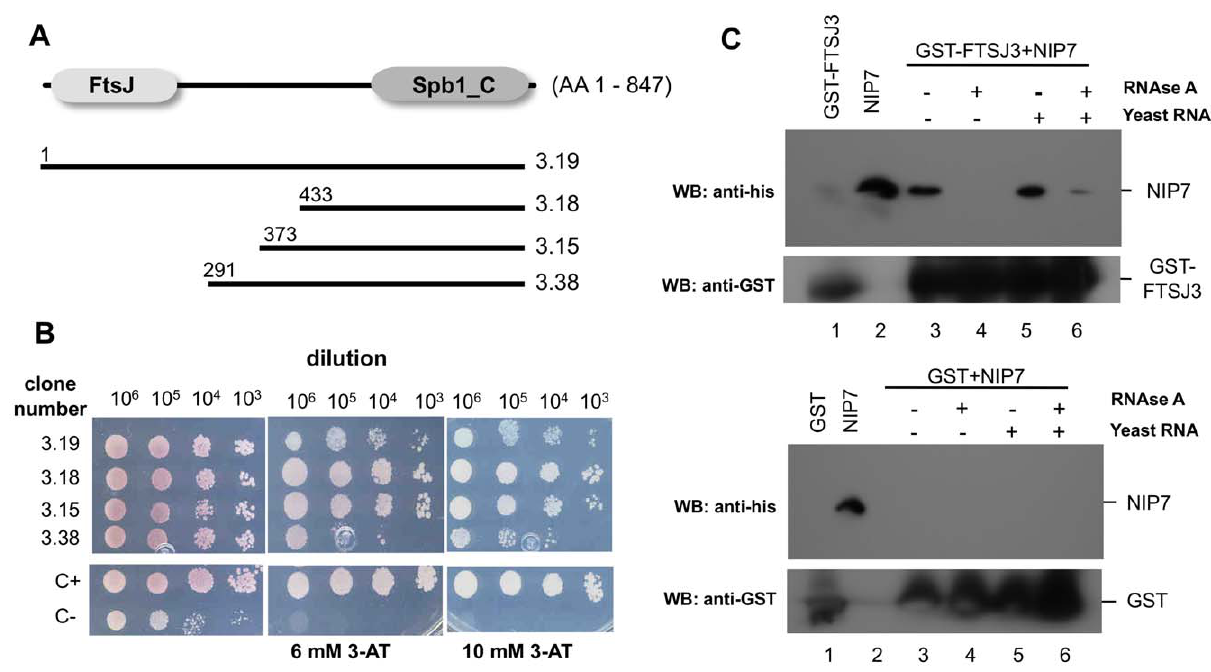
Figure 1. Isolation and validation of FTSJ3 as a bona-fide interaction partner of NIP7. ( A ) Diagram of the FTSJ3 protein (adapted from PFAM database) and cDNA clones showing positive interaction with NIP7 in the yeast two-hybrid system. Conserved domains, FtsJ and Spb1_C, are shown in grey boxes. Bars represent the length of each cDNA isolated in the yeast two-hybrid screen. The first amino acid encoded by the truncated cDNAs is indicated on the left. ( B ) Dilution-based growth assays of yeast cells tested for HIS3 expression as a reporter of two-hybrid interactions between NIP7 and human cDNAs indicated on the left (top panel). A positive control for two-hybrid interaction (C + , yeast strain L40 expressing lex A- Nip7p and AD-Nop8p) and negative control (C 2 , yeast strain L40 expressing lex A-NIP7 and GAL4AD) are shown in the bottom panel. Dilutions of cells are shown on the top and 3-aminotriazole concentrations employed are indicated on the bottom. ( C ) Interaction assays using recombinant His-NIP7 and GST-FTSJ3. GST-FSTJ3 (upper panel) and GST (lower panel) were immobilized on gluthathione-sepharose beads and the indicated samples ( + ) were treated with RNase. Subsequently, purified His-NIP7 was added to the binding reactions. Yeast total RNA was also added to the indicated samples ( + ). Bound His-NIP7 was detected by immunoblotting using an anti-histidine antibody. Immunoblotting using a GST antibody was used to detect GST-FTSJ3 as indicated. RNase A treatment abolishes His-NIP7-GST-FTSJ3 interaction.